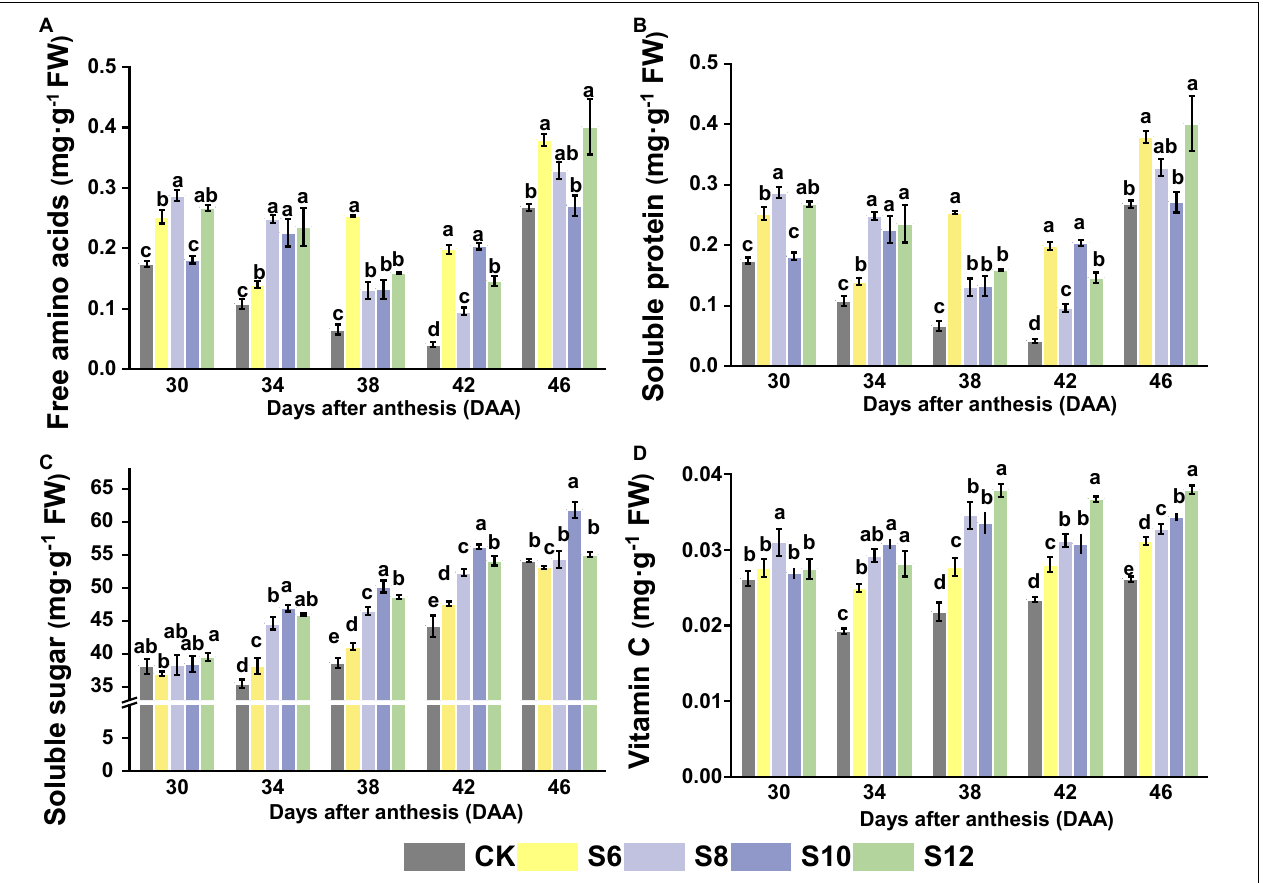
FIGURE 6 | Effects of different supplemental blue light frequencies on the (A) free amino acids content, (B) soluble protein content, (C) soluble sugar content, and (D) vitamin C content of tomato fruit. Values are means ± SD ( n = 3). Different letters denote significant differences among treatments at each sampling day after anthesis separately ( p ≤